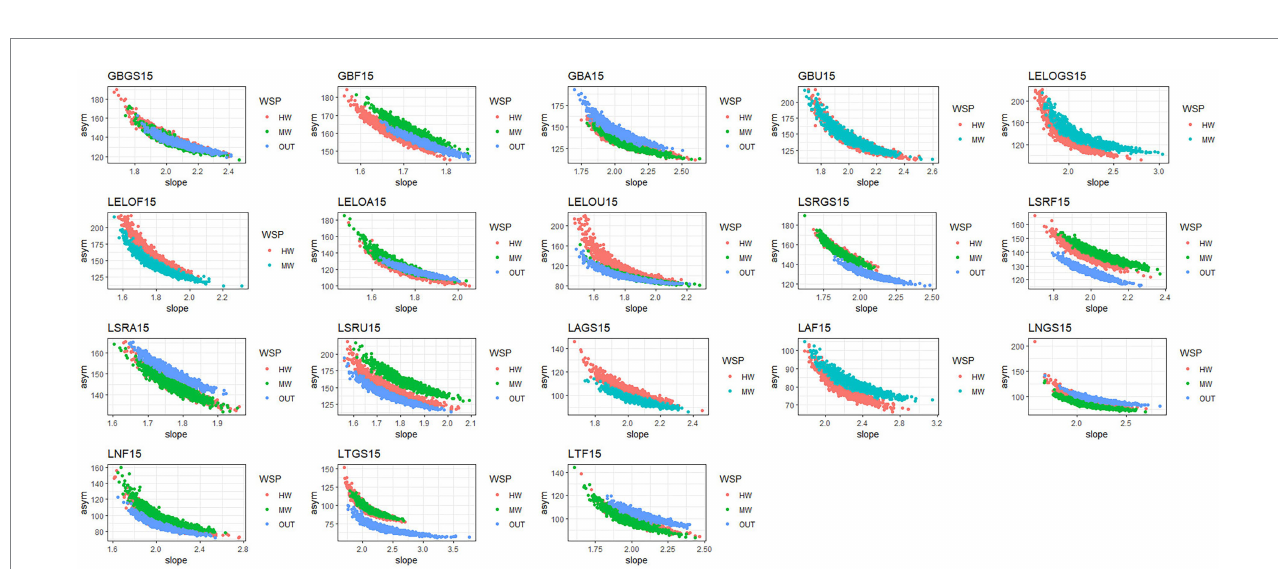
FIGURE 5 Scatterplots showing the relationship between slopes and asymptotes within each subgroup. Key: -Ecoregion: GB- Georgian Bay, LELO- Lake Erie Lake Ontario, LSR - Lake Simcoe Rideau, LN - Lake Nipigon LA- Lake Abitibi, LT - Temagami. Landcover: F- Forest, A- Agricultural, GS- Greenspace, U-